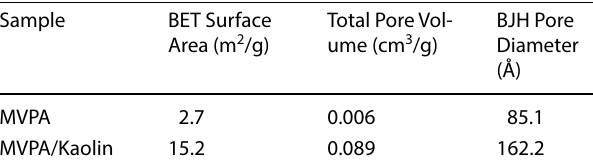
Table 1 Important adsorption–desorption data for MVPA and MVPA/Kaolin Sample BET Surface Area (m 2